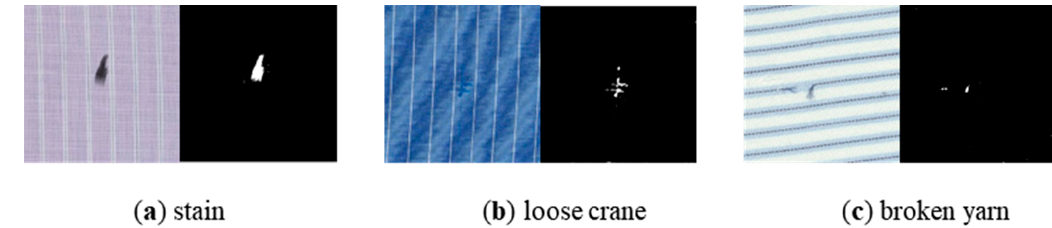
Figure 13. Dot-patterned fabric defect of detection results.